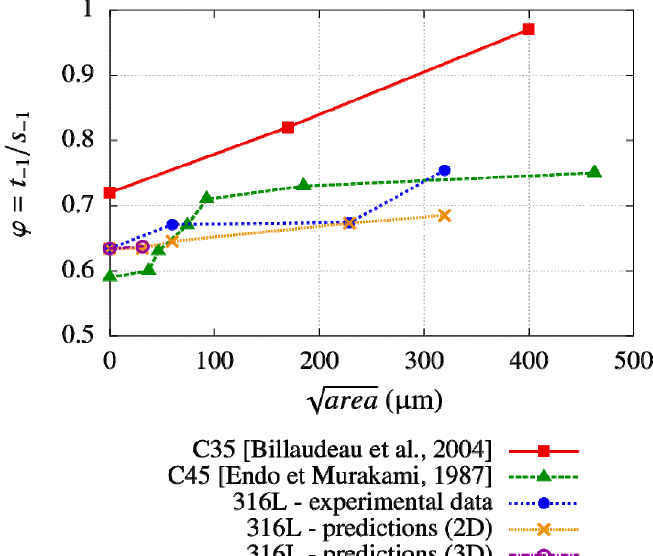
Figure 6: Comparison between the experimental and the predicted ratios of the fatigue limits under fully-reversed torsion t -1 and fully reversed tension s -1 : t -1 /s